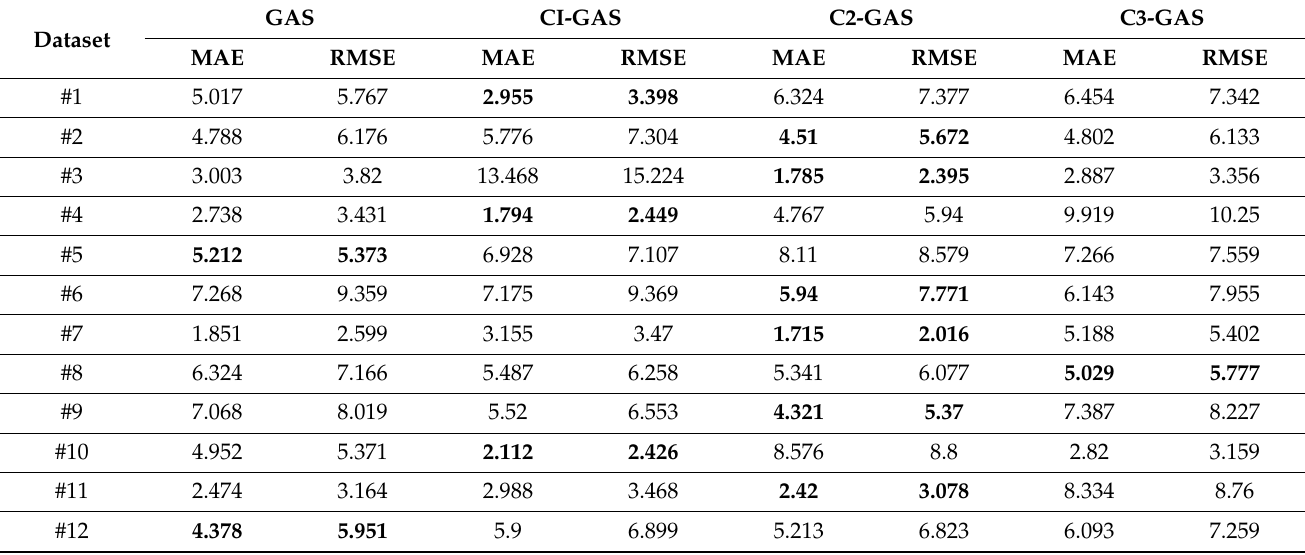
Table 5. MAE and RMSE values using the GAS and clustered GAS models